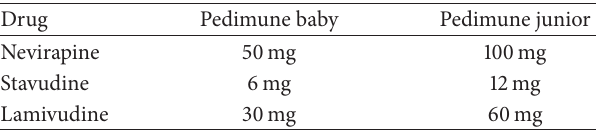
Table 1: Pedimune composition for